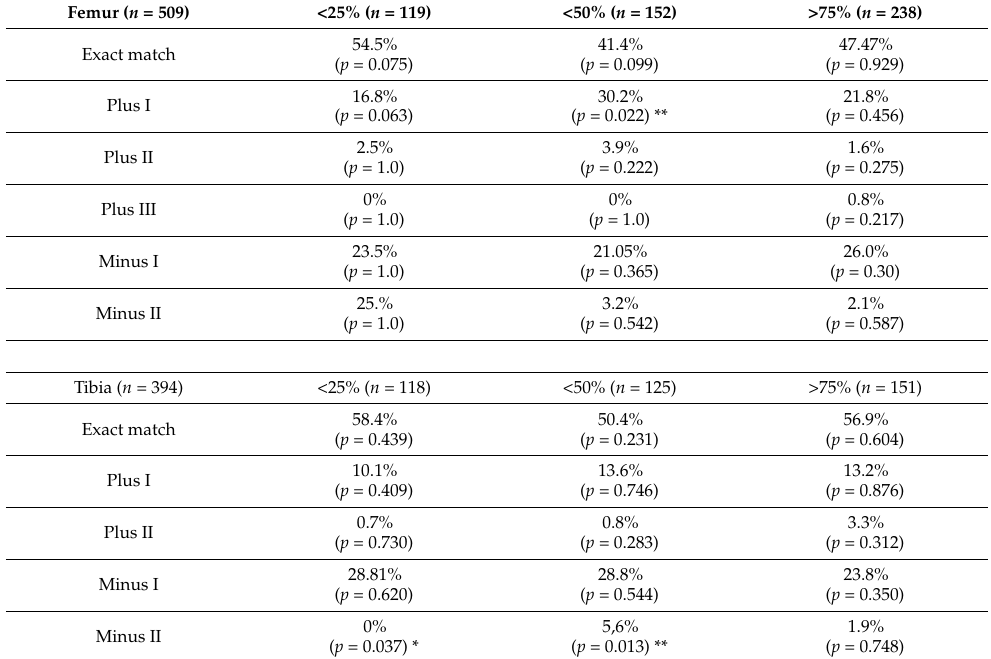
Table 4. Femoral and tibial planning adherence in relation to surgeon experience; p -values from each Fischer’s exact test. Each experience group and the match were tested against all other groups and matches. * = significantly less often implanted against all other experience groups, ** = significantly more often implanted than all other experience groups.